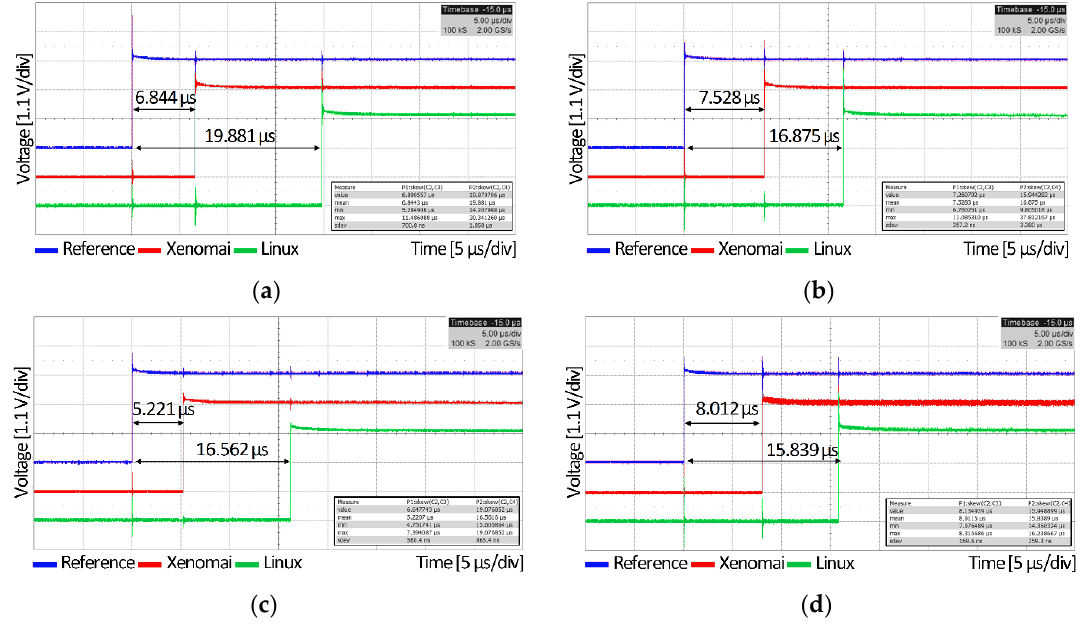
Figure 6. Comparison of interrupt response times of Xenomai and the standard Linux on different OES: ( a ) BeagleBone Black; ( b ) Raspberry Pi 3 ( c ) Zybo-7020; ( d ) i.MX6Q SABRELite.